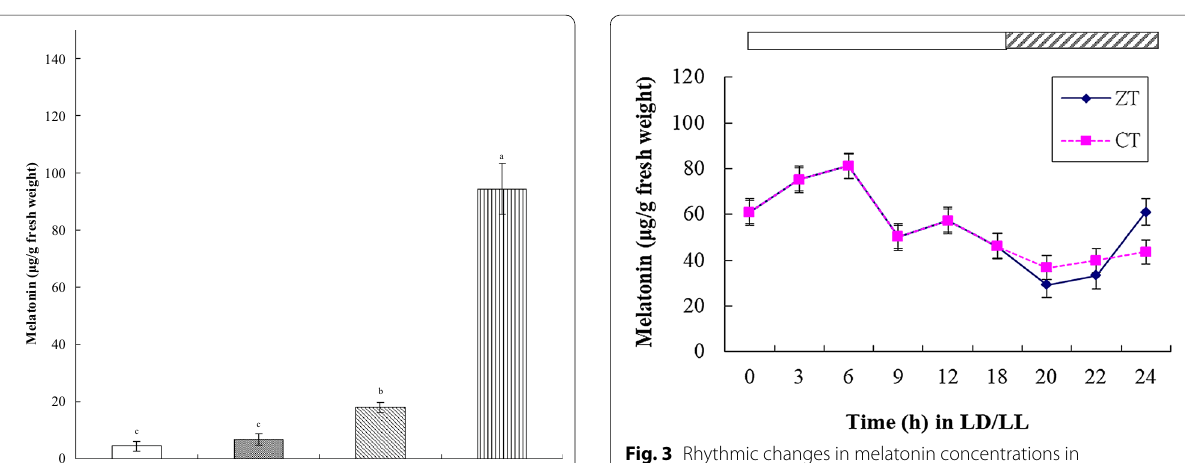
Temporal regulation and mechanism of melatonin concentration in H. perforatum L.